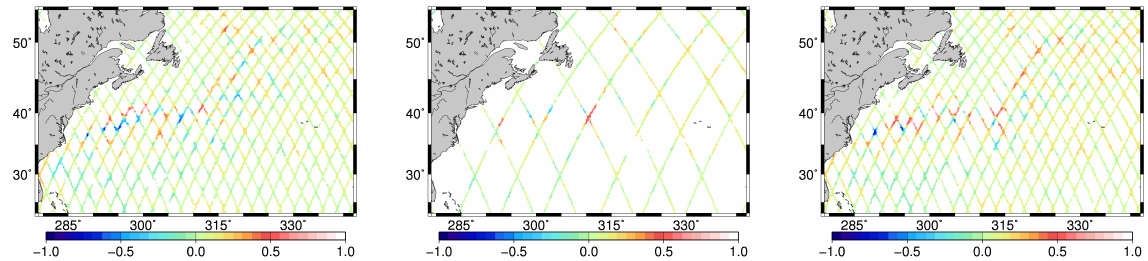
Figure 8. SSH Jason-tracks coverage for three successive 10-day cycles from 7 September to 7 October